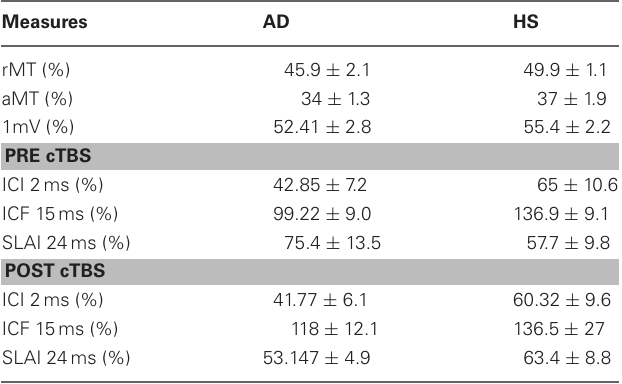
Table 1 | Parameters of corticospinal excitability before and after cTBS.